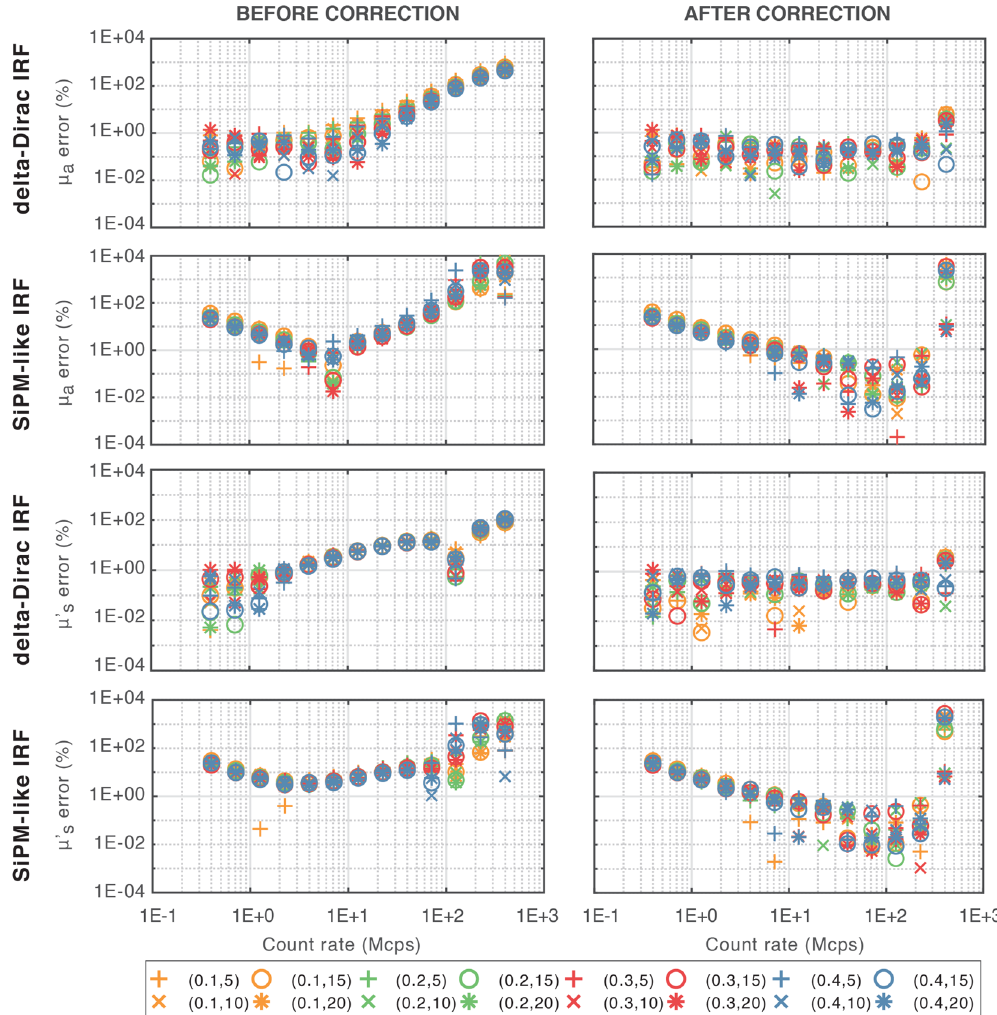
Figure 1. MEDPHOT protocol results for simulated data. Values obtained with delta-Dirac IRF are represented in odd rows, while those obtained with a SiPM-like IRF are in even ones. Each single point represents the absolute error for a particular phantom. Marker colors refer to different absorption coefficients, while marker types to different scattering ones. Absorption (first and second rows) and reduced scattering (third and fourth rows) coefficients errors are represented at various CRs, for all the phantoms. In all cases, both results before (left plots) and after (right plots) correction are